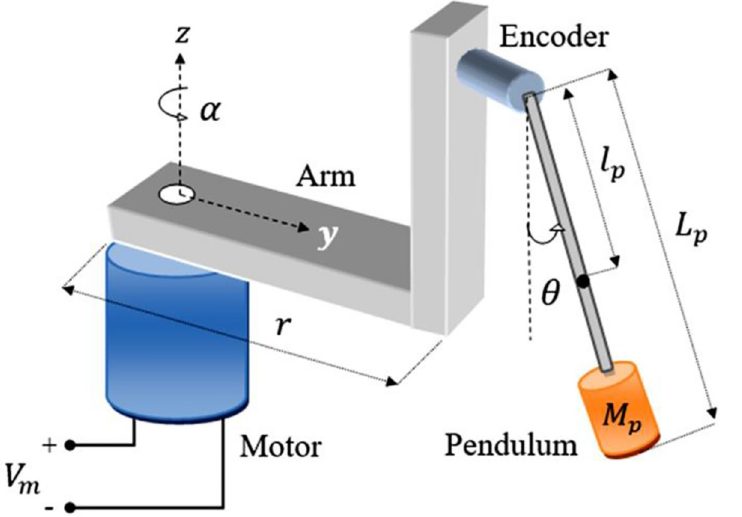
Fig 1. Hardware schematic of a typical rotary pendulum